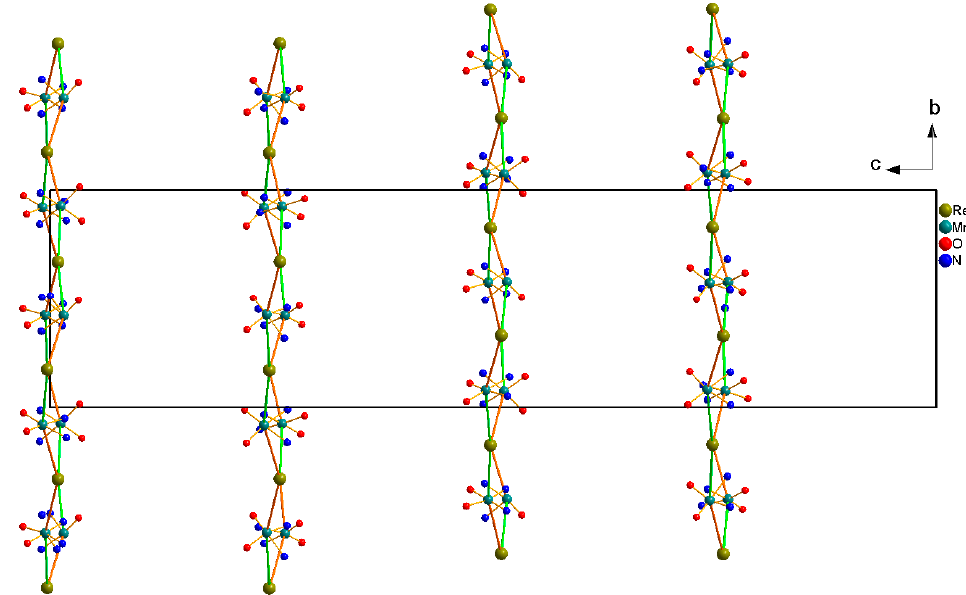
Figure 20. A view of four layers in 14 along the a axis. The Re-CN apical —{MnN 2 O 2 } and Re-CN equato- rial —{MnN 2 O 2 } connections are colored in green and orange, respectively [56].